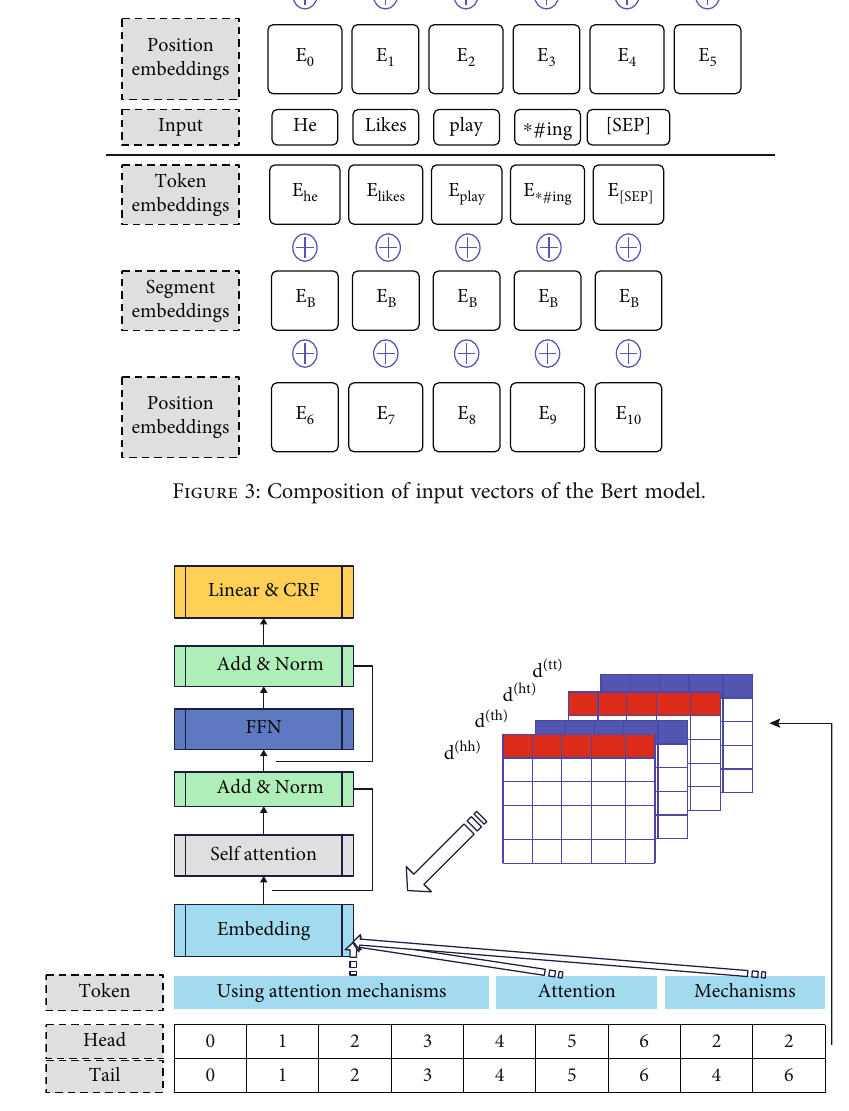
Figure 4: The model structure diagram of the imported